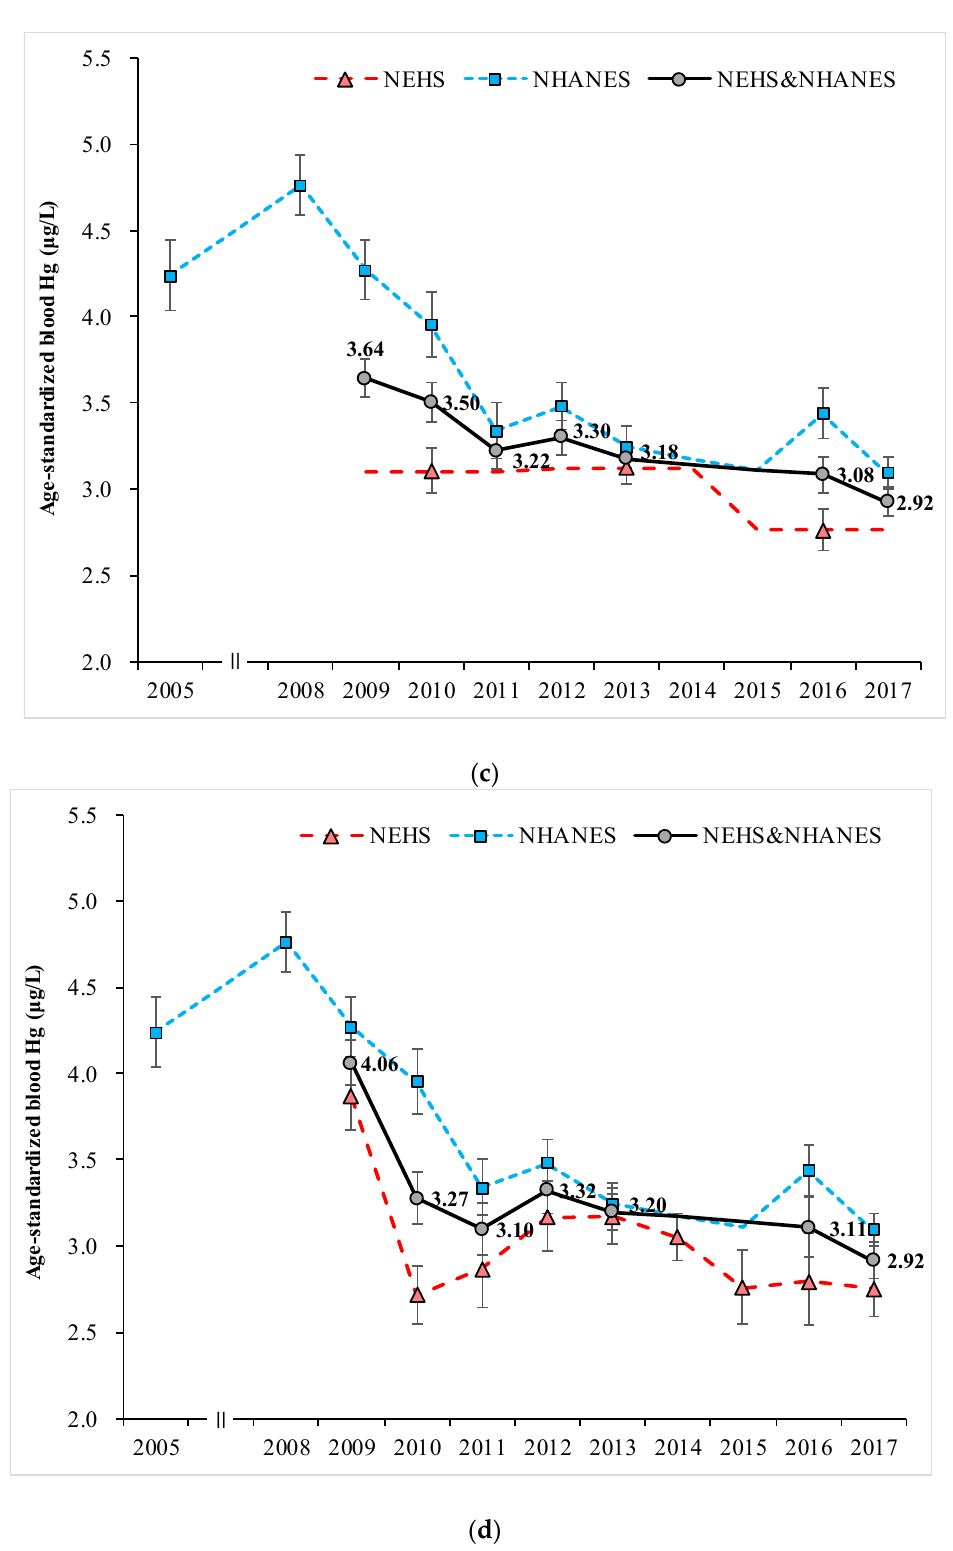
Figure 3. Geometric mean profiles of blood Pb and Hg concentrations. ( a ) Geometric mean profile of blood Pb concentration in integrated data using method 1; ( b ) geometric mean profile of blood Pb concentration in the integrated data by method 2; ( c ) geometric mean profile of blood Hg concentration in integrated data using method 1; ( d ) geometric mean profile of blood Hg concentration in integrated data using method 2. KNEHS, Korean National Environmental Health Survey; KNHANES, Korea National Health and Nutrition Examination Survey.